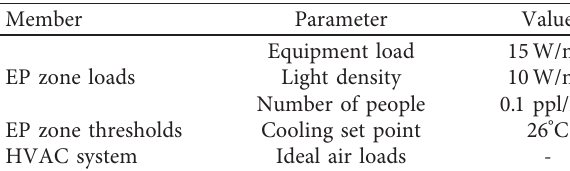
Table 7: Zone energy